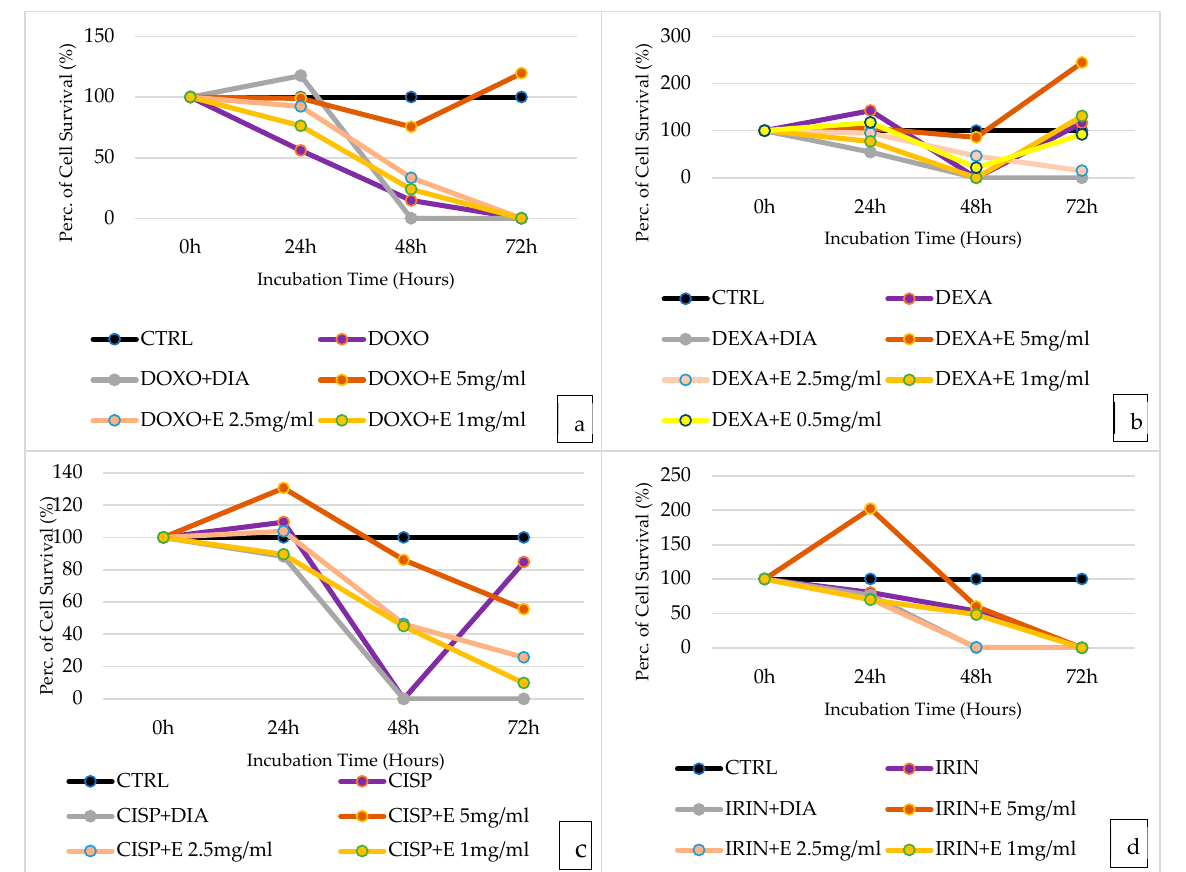
Figure 7. ( a ) Percentage of cell growth values of HEK293 cells co-incubated with doxorubicin (DOXO), doxorubicin and diazoxide (DOXO + DIA), and doxorubicin and various concentrations of the extract (DOXO + E) measured using the crystal violet assay, compared to controls (CTRL). Data are shown for various concentrations of the extract (5 mg/mL, 2.5 mg/mL, 1 mg/mL) after 0 h, 24 h, 48 h, and 72 h of incubation, using the drug doxorubicin (DOXO) in the purple lines, doxorubicin and diazoxide (DOXO + DIA) in gray lines, and doxorubicin with the various concentrations of the extract (DOXO + E) in orange lines. ( b ) Percentage of cell growth values of HEK293 cells co-incubated with dexamethasone (DEXA), dexamethasone and diazoxide (DEXA + DIA), and dexamethasone and various concentrations of the extract (DEXA + E) measured using the crystal violet assay, compared to controls (CTRL). Data are shown for various concentrations of the extract (5 mg/mL, 2.5 mg/mL, 1 mg/mL, 0.5 mg/mL) after 0 h, 24 h, 48 h, and 72 h of incubation, using the drug dexamethasone (DEXA) in the purple lines, dexamethasone and diazoxide (DEXA + DIA) in gray lines, and dexamethasone with the various concentrations of the extract (DEXA + E) in orange and yellow lines. ( c ) Percentage of cell growth values of HEK293 cells co-incubated with cisplatin (CISP), cisplatin and diazoxide (CISP + DIA), and cisplatin and various concentrations of the extract (CISP + E) measured using the crystal violet assay, compared to controls (CTRL). Data are shown for various concentrations of the extract (5 mg/mL, 2.5 mg/mL, and 1 mg/mL) after 0 h, 24 h, 48 h, and 72 h of incubation, using the drug cisplatin (CISP) in the purple lines, cisplatin and diazoxide (CISP + DIA) in gray lines, and cisplatin with the various concentrations of the extract (CISP + E) in orange lines. ( d ) Percentage of cell growth values of HEK293 cells co-incubated with irinotecan (IRIN), irinotecan and diazoxide (IRIN + DIA), and irinotecan and various concentrations of the extract (IRIN + E) measured using the crystal violet assay, compared to controls (CTRL). Data are shown for various concentrations of the extract (5 mg/mL, 2.5 mg/mL, and 1 mg/mL) after 0 h, 24 h, 48 h, and 72 h of incubation, using the drug irinotecan (IRIN) in the purple lines, irinotecan and diazoxide (IRIN + DIA) in gray lines, and irinotecan with the various concentrations of the extract (IRIN + E) in orange lines.